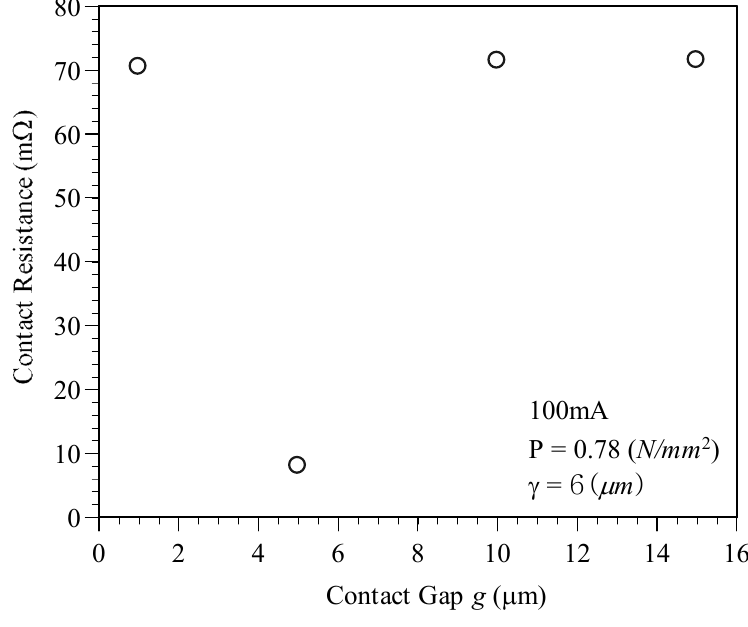
Figure 11. Variation in switching time used in the thermal-electrical coupling finite element